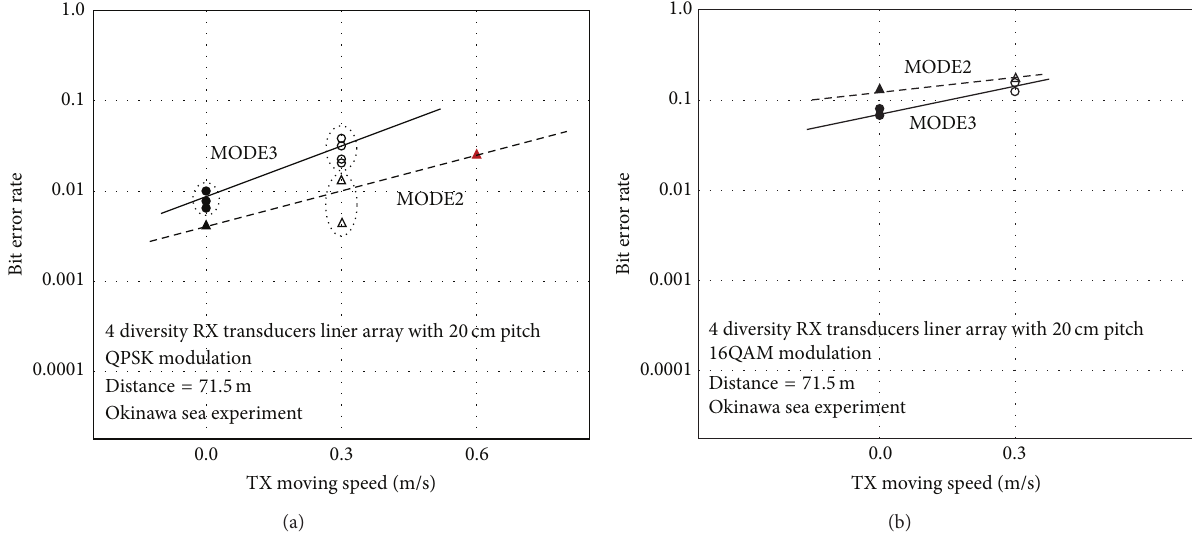
Figure 11: (a) Communication system performance using QPSK modulation. (b) Communication system performance using 16QAM